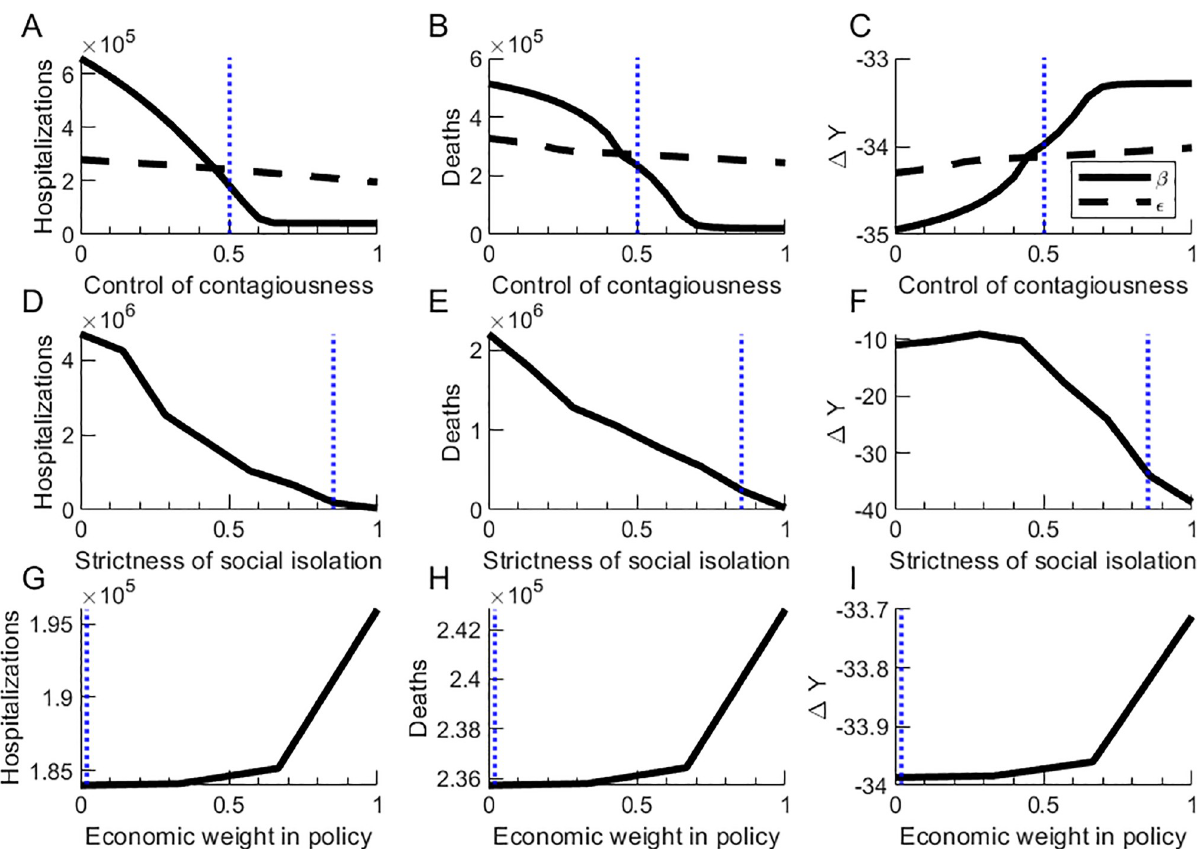
Fig 6. Sensitivity analysis. a-c . Total hospitalizations, deaths, and net change in economic productivity for one and a half years depending on the control of contagiousness of asymptomatic ( β ) and hospitalized ( � ) individuals. d-f . Total hospitalizations, deaths, and net change in economic productivity for one and a half years depending on the strictness of enforcement of isolation policies. g-i . Total hospitalizations, deaths, and net change in economic productivity for one and a half years depending on the relative importance of the economic situation in the public policies. The blue dotted vertical lines mark the values used in the baseline